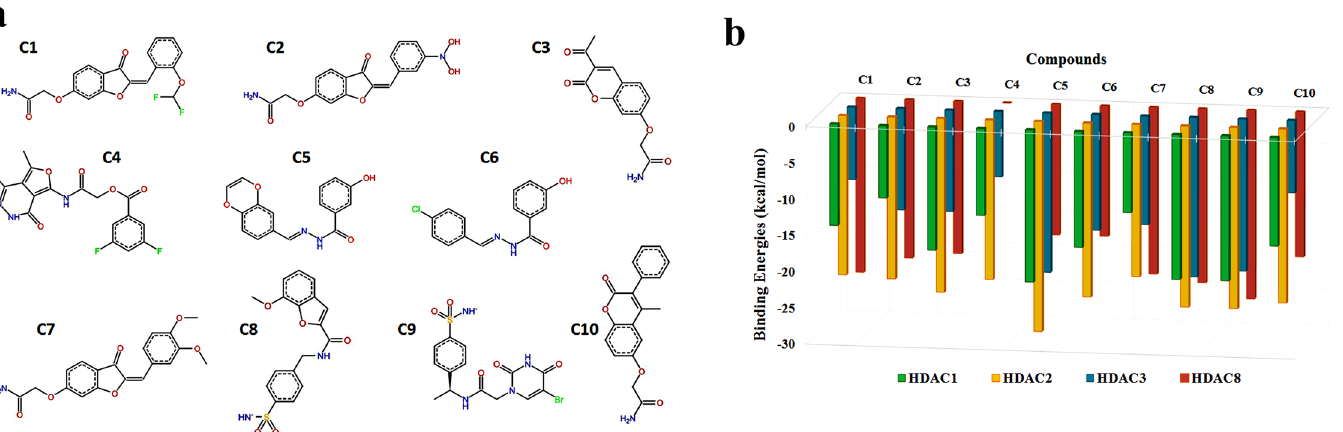
PLOS ONE | DOI:10.1371/journal.pone.0139588 October 2,